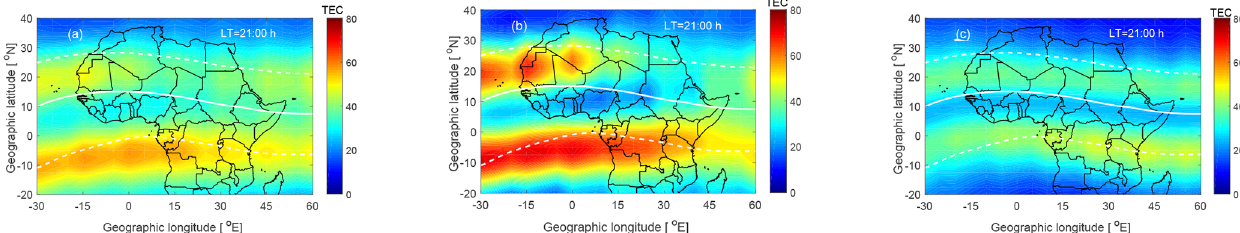
Figure 7. EOF TEC (a) , CODE’s TEC (b) and the IRI TEC (c) for the DOY 070 in 2015. Shown on the plots are the local times in hours. The horizontal curved solid white lines show the geomagnetic dip equator. The dashed white lines show the anomaly region at ± 15 ◦ geomagnetic latitude from the dip equator.